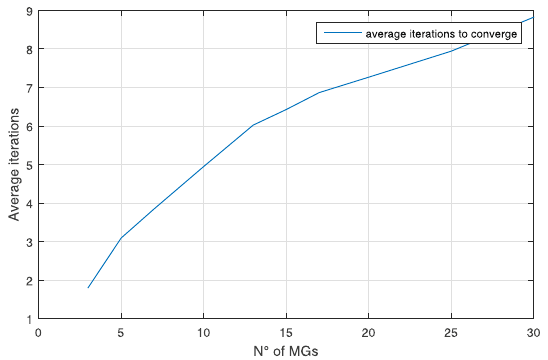
Fig. 5 Average iterations to final state -Matching-